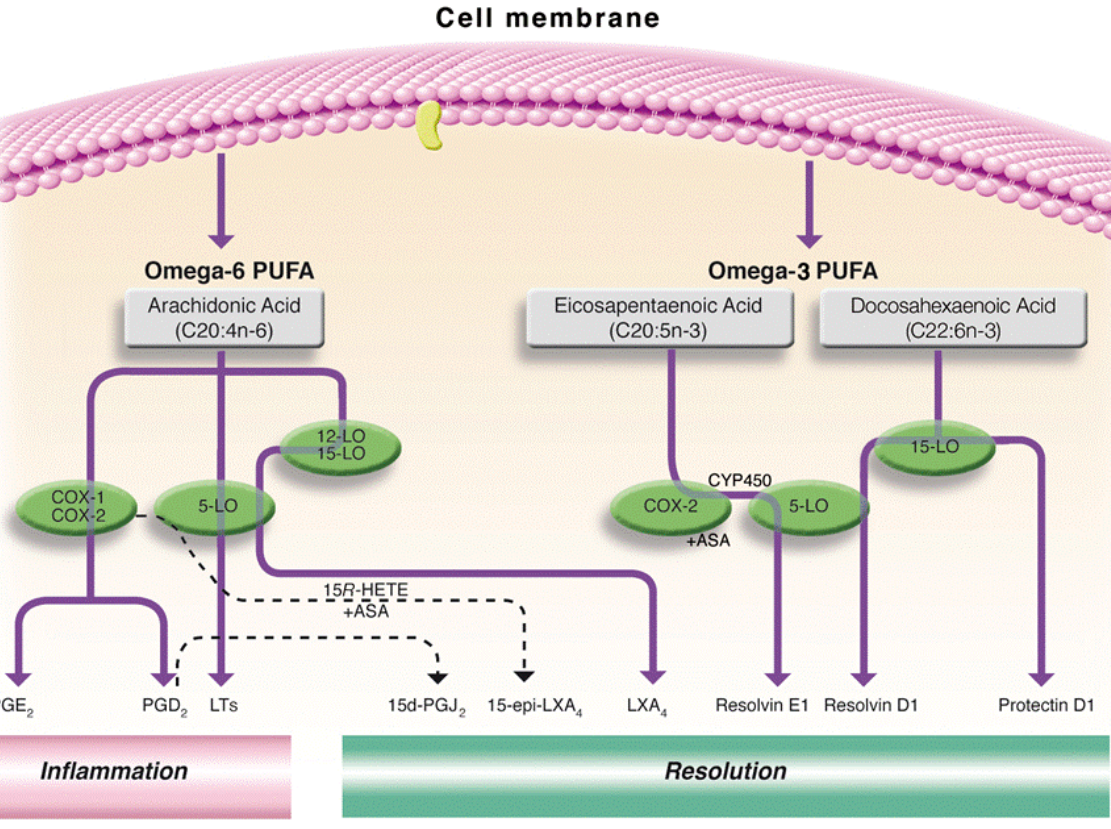
FIGURE 2. Protective ω-6– and ω-3–derived circuits in inflammation. The ω-6 PUFA arachidonic acid is released from phospholipids and U metabolized by COX or 5-LO to form inflammatory mediators, such as PGs and LTs. During the process of resolution, there is a ―class switch‖ from the biosynthesis of these inflammatory mediators to the formation of lipid autacoids with anti-inflammatory and proresolving properties, including the LXs and the cyclopentenone PGs of the D series (15d-PGJ 2 ). In addition, during the resolution of inflammation, ω- 3 PUFAs such as EPA and docosahexaenoic acid (DHA) are converted to potent anti-inflammatory and proresolving lipid mediators, including resolvin E1, resolvin D1, and protectin D1. ASA: aspirin, CYP450: cytochrome P450.